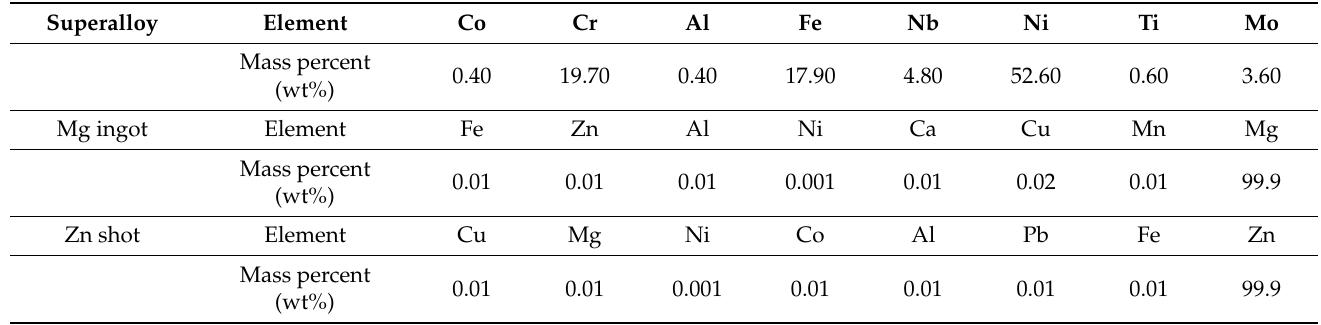
Table 1. Chemical composition of the superalloy, Mg and Zn used in this study.